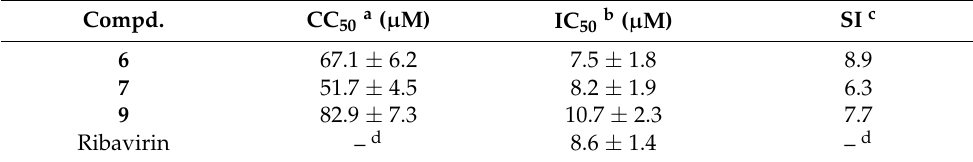
Table 3. Cytotoxicity and anti-NDV activity of 1-formyl- β -carboline derivatives. Compd.